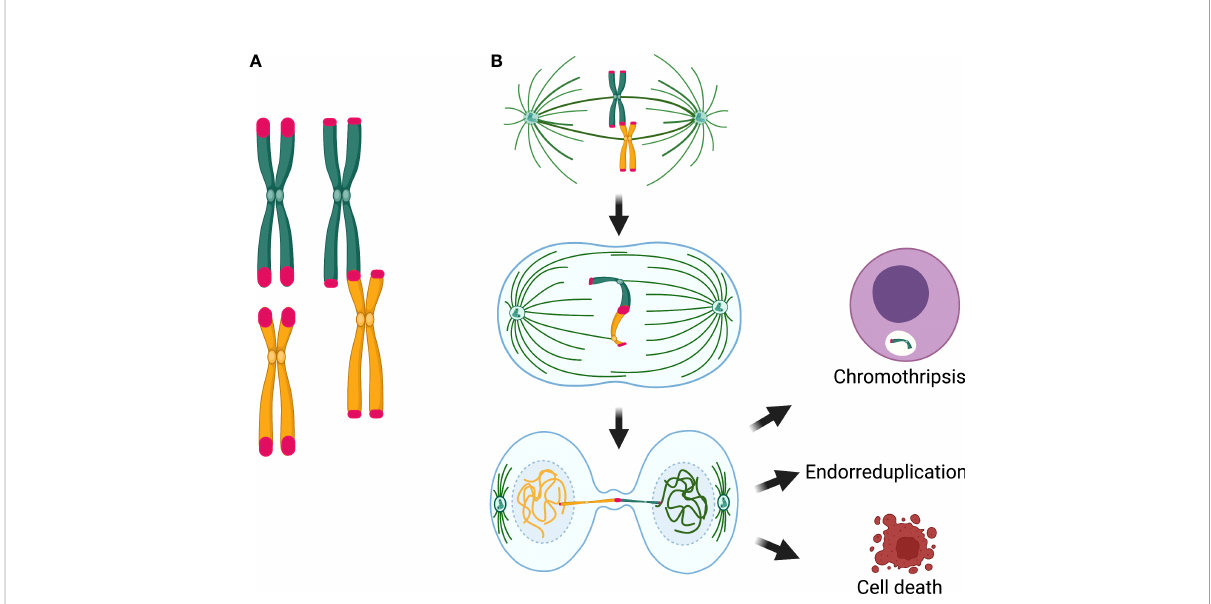
FIGURE 5 Chromosomal consequences of telomere attrition. (A) Telomere attrition produces telomere fusions that originate dicentric chromosomes. (B) Segregation of the dicentric when the two centromeres are pulled by opposite poles of the mitotic spindle is the main source of chromosome and cell abnormalities, because the dicentric may induce a breakage – fusion – bridge cycle. If the chromatin of the dicentric bridge is enzymatically fragmented or if the dicentric breaks and a micronucleus is formed, gross structural rearrangements, such as chromothripsis, may arise in the daughter cells. Alternatively, when chromatin bridges are not resolved, interruption of mitosis and cytokinesis, may lead to polyploid cells and endorreduplicated chromosomes in the next mitosis. Until now, chromothripsis has not been detected in cells from patients with DC/ TBD; however, anaphase bridges, fragmentation of a single chromosome, which is the precedent of chromothripsis, endoreduplications, and polyploidy have been found in DC